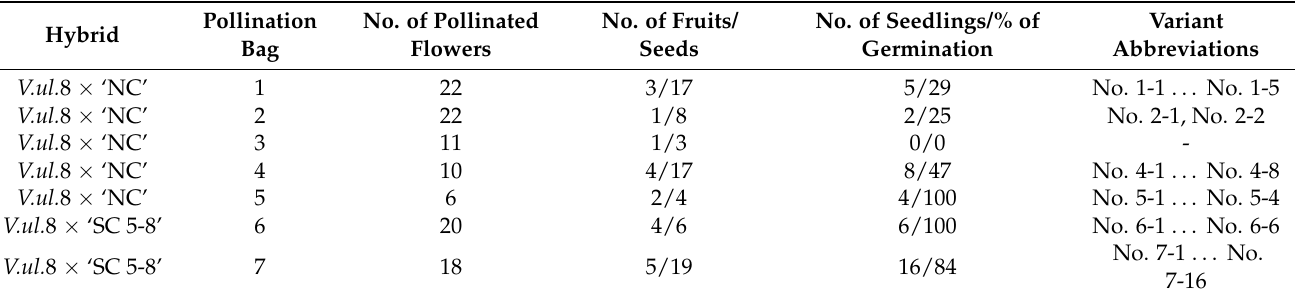
Table 1. The number of pollinated flowers, set fruits, seeds, and the percentage of germination of Vaccinium uliginosum ×